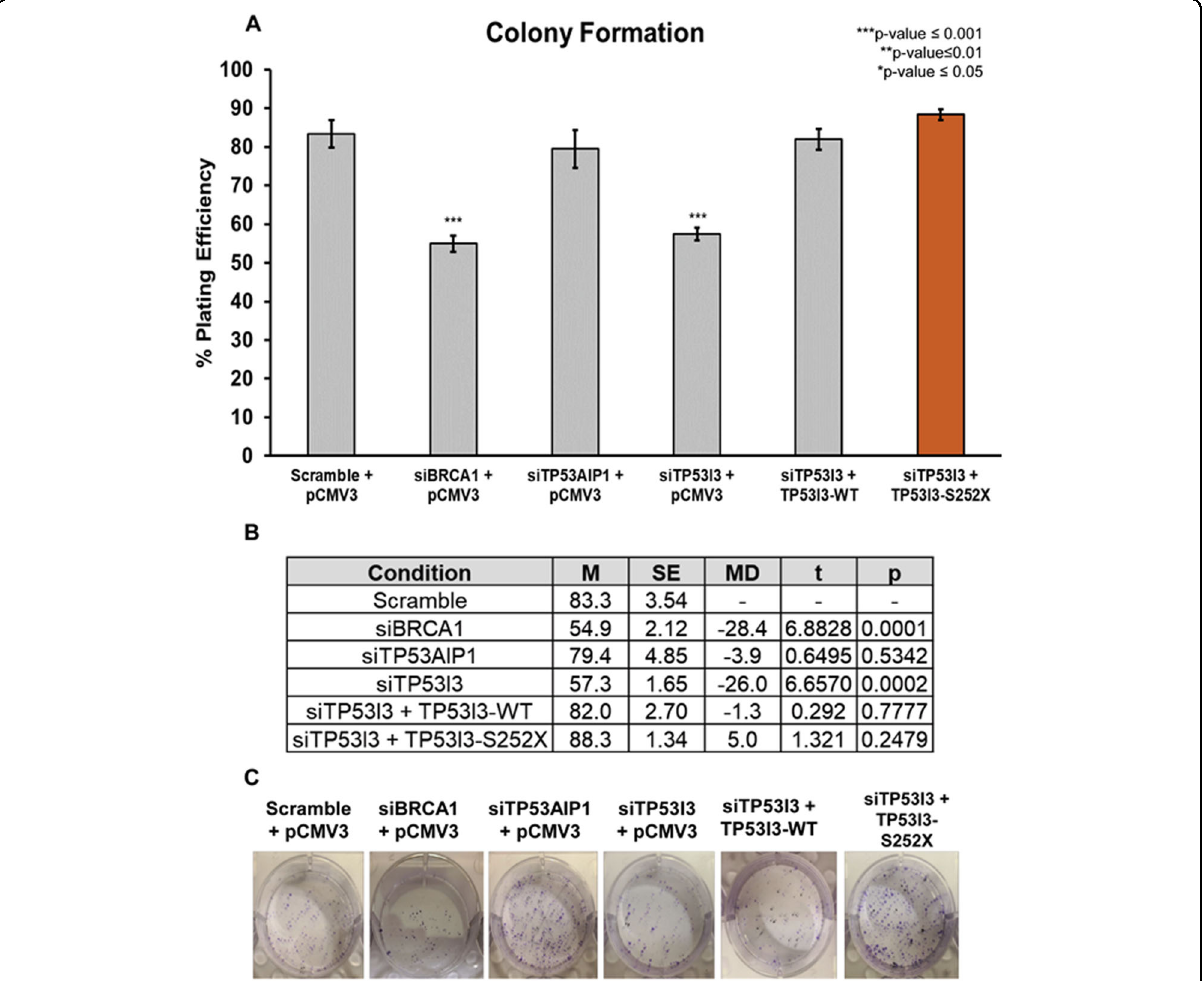
Fig. 4 Effect TP53I3-S252X and TP53AIP1 on cell colony formation. A The percent plating ef fi ciency on the y axis after knockdown of proteins with empty vector (pCMV3). The population of TP53I3 knockdown cells was rescued with TP53I3-WT or TP53I3-S252X mutant. B Calculated two-way t test for each condition compared with scramble-positive control. With an n = 5, p values ≤ 0.05 were considered statistically signi fi cant. C Representative qualitative images of each condition. The signi fi cance test was based on comparing the positive control, Scramble and SCE1, to knockdown and/or rescue